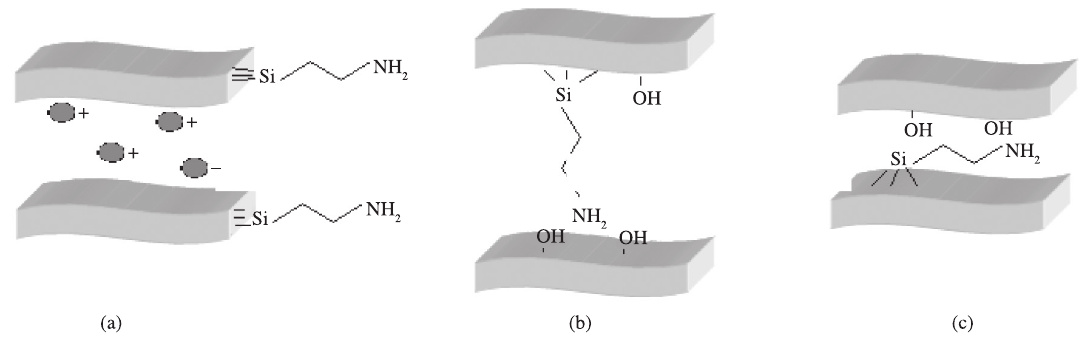
Figure 4. Proposed interaction of the amino centers attached to pendant organic chains with available acidic silanol groups of the lamella for the solid V1-N.